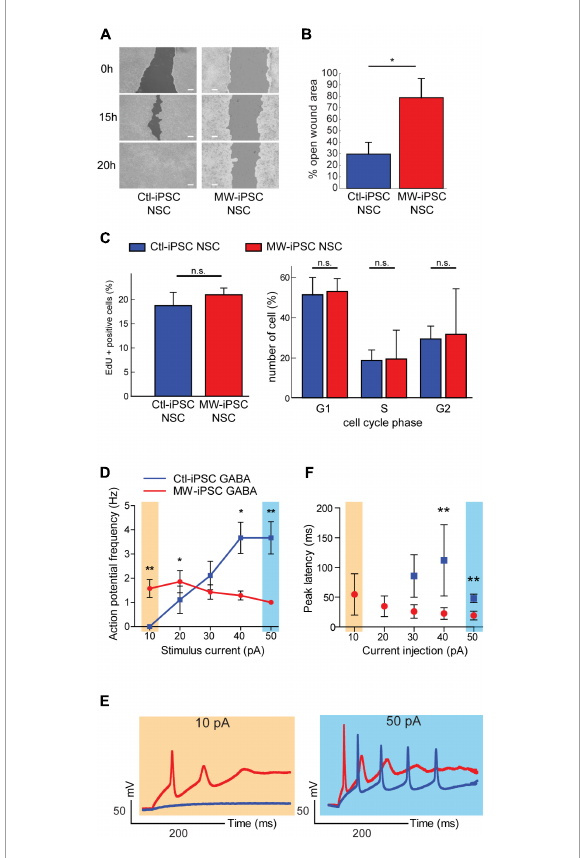
FIGURE5 MW-iPSC derived neural cells with ZEB2 haploinsufficiency show impaired migration and altered electrophysiology. (A,B) Assessment of cell motility of iPSC-NSCs at day 10 using a wound healing scratch assay shows impaired motility in MW-iPSC NSCs. (A) Confluent cultures of MW-iPSC NSCs and Ctl-iPSC NSCs at day 10 were scratched and imaged at identical positions after 0 h, 15 h and 20 h. Representative pictures are shown. Size bar 200 µ m. (B) Quantification of open wound area in MW-iPSC NSCs and Ctl-iPSC NSCs using TScratch software. The remaining open area was quantified at 15 h vs. 0 h (3 replicates per iPSC line) and significantly larger in